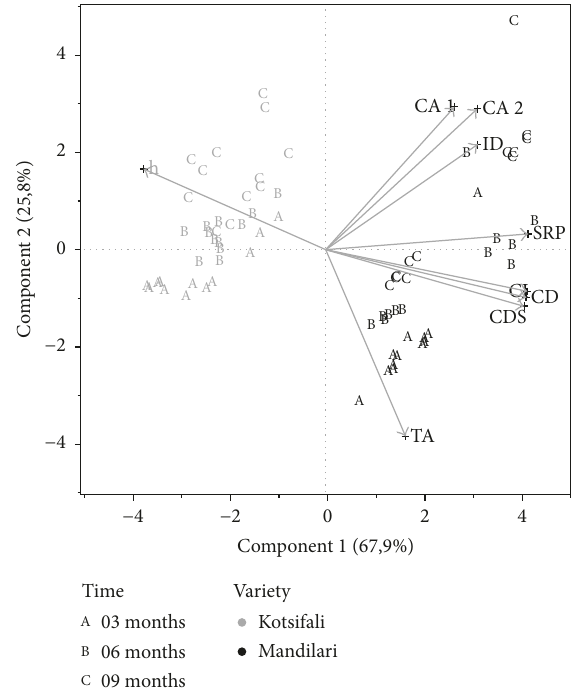
Figure 1: Biplot of principal components 1 and 2 for mean scores of Kotsifali and Mandilari color parameters.